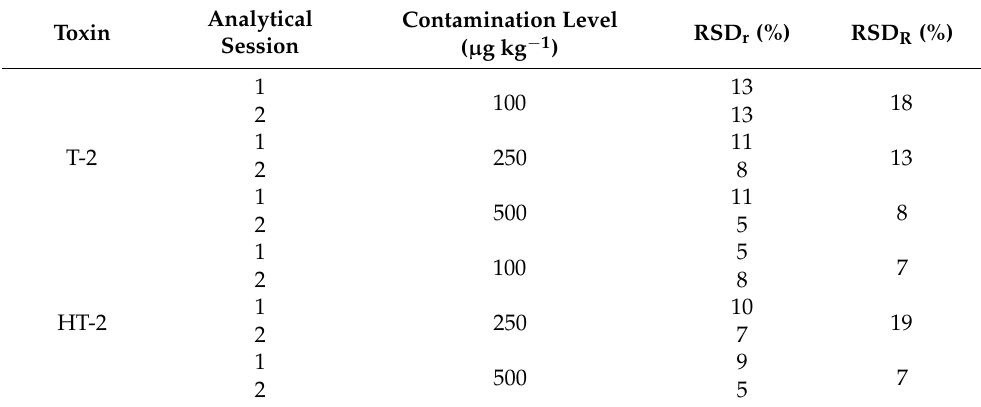
Table 3. UPLC/FLD intra-day and inter-day precision studies on durum wheat samples spiked with the T-2 and HT-2 toxins.